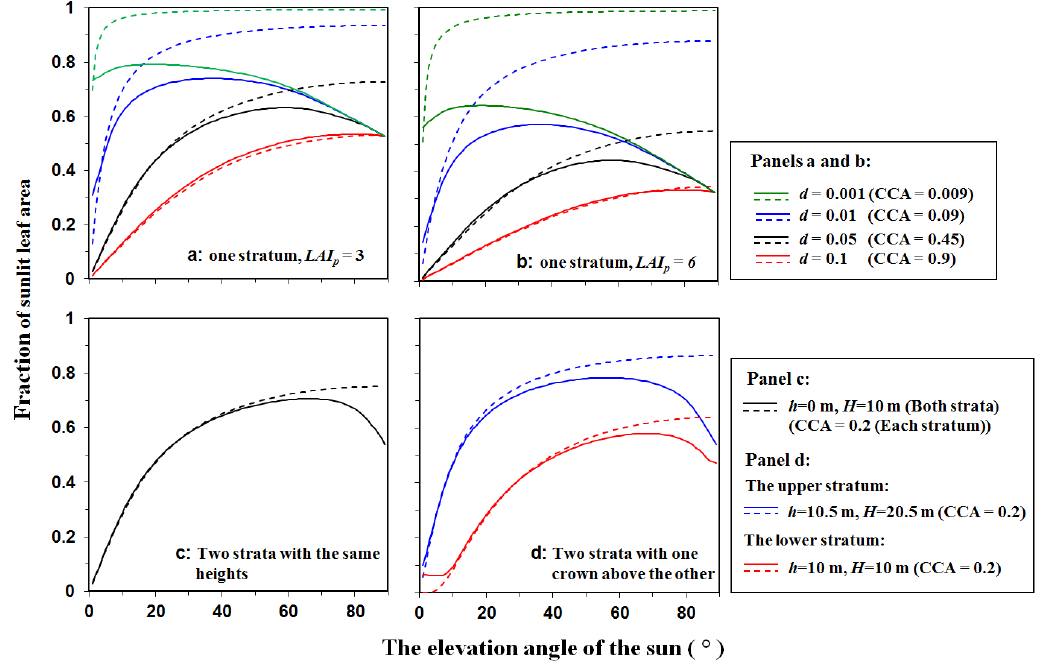
Figure 12. Comparisons of the calculated sunlit leaf area fractions between the IPR model (solid curves) and the two-big-leaf method (dashed curves). Panels (a) and (b) are for one-stratum plant communities with different local leaf area index (LAI p ) and plant densities ( d) (shown in each panel and the legend). The other parameters are the same: the bottom height of the crown h = 0m, the top height of the crown H = 10m, and crown width D = 3m. The fraction of crown covered area (CCA) was calculated by D 2 · d and is also shown in the legend. Panels (c) and (d) are for two-stratum plant communities with the same crown heights and one crown above the other, respectively (crown heights and CCA are shown in the legend). The other crown parameters are the same: crown width D = 1m, local leaf area index LAI p = 3, and plant density d = 0.2plantsm − 2 . For the two-big-leaf method, the leaf area index of a stratum was calculated as D 2 · d · LAI p